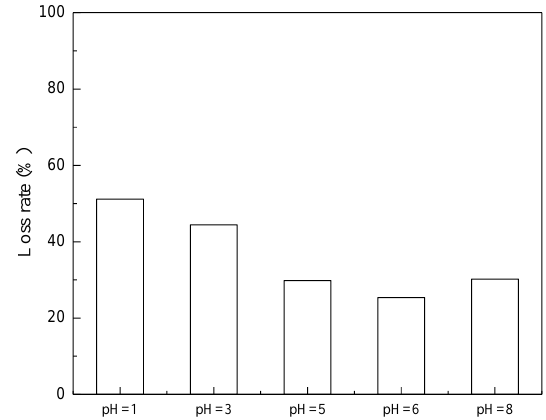
Figure 6. Amino acid loss rate at different pH values.